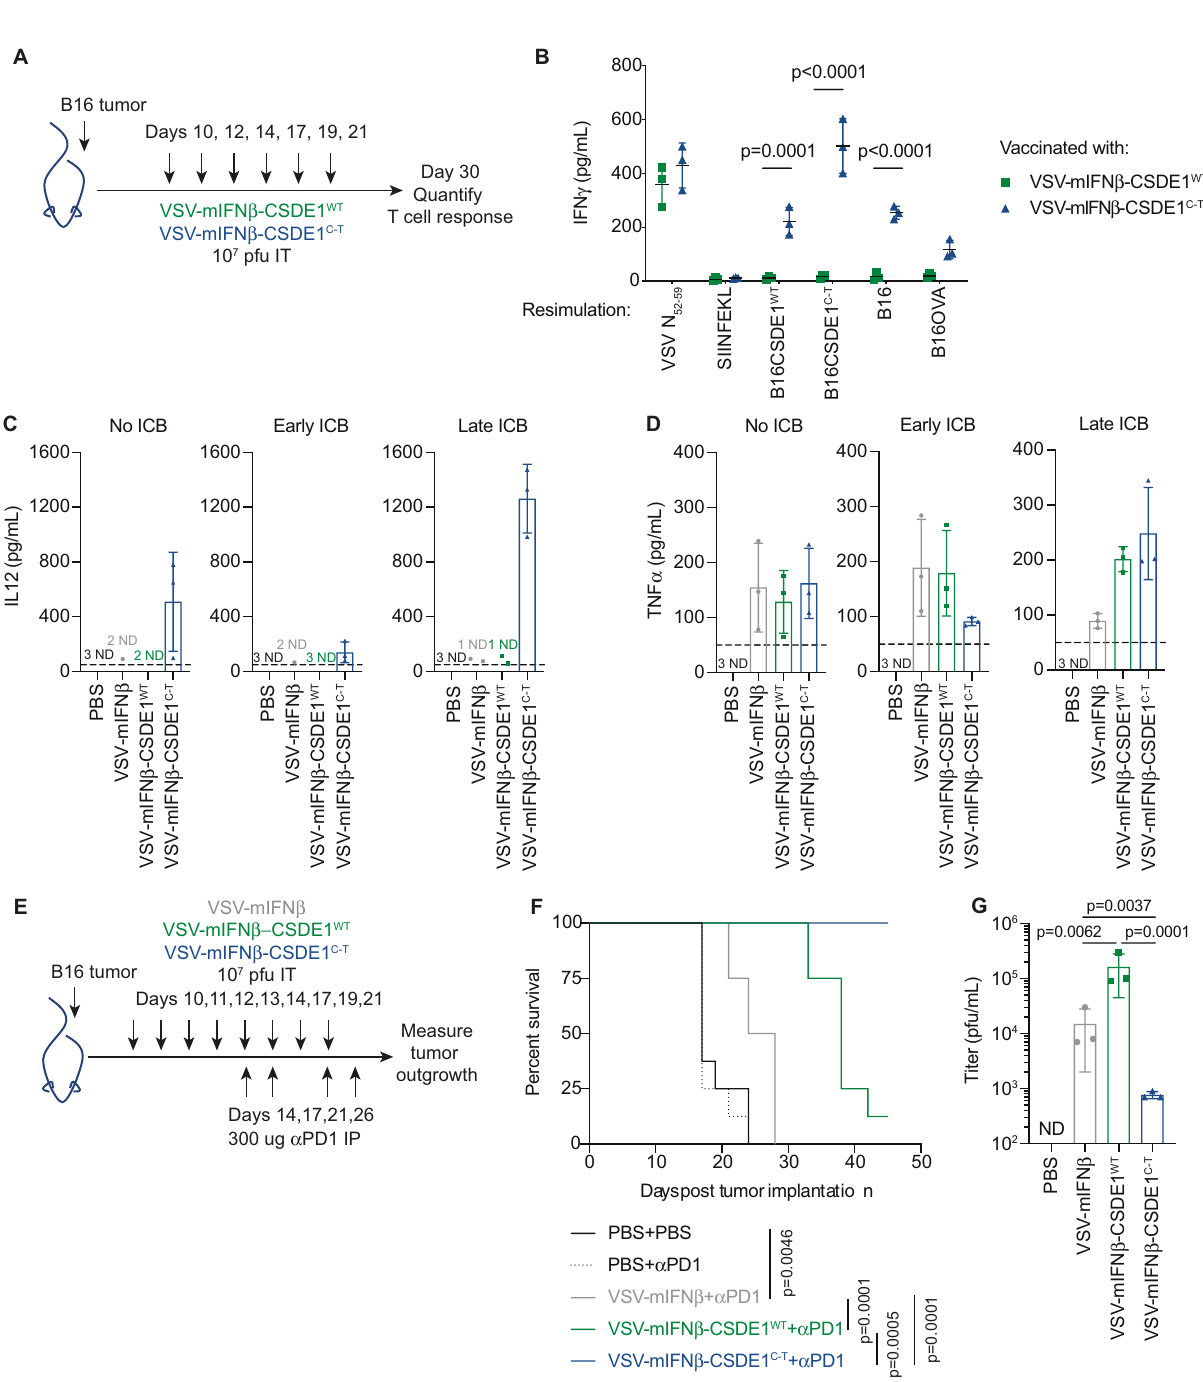
expressing CSDE1 P5S . DC-CSDE1 C-T also generated strong α - CSDE1 P5S T-cell responses (Supplementary Fig. 2A, B). VSV- IFN β + DC-CSDE C-T + α -PD-1 signi fi cantly enhanced therapy relative to VSV-IFN β + DC-CSDE WT + α -PD-1 (Supplementary Fig. 2C), but never achieved the 100% cure rates of VSV-IFN β - CSDE1 C-T + α -PD-1 (Fig. 5F), which correlated with ~3-fold lower levels of i.t. IL-12 (Supplementary Fig. 2D and Fig. 5C). Human tumor cells that escape VSV-IFN β are immunogenic . We investigated whether CSDE1 P5S , and other unde fi ned EATA, would be immunogenic for human T cells. In three separate co-cultures, CD3/CD28-activated human CD3 + T cells